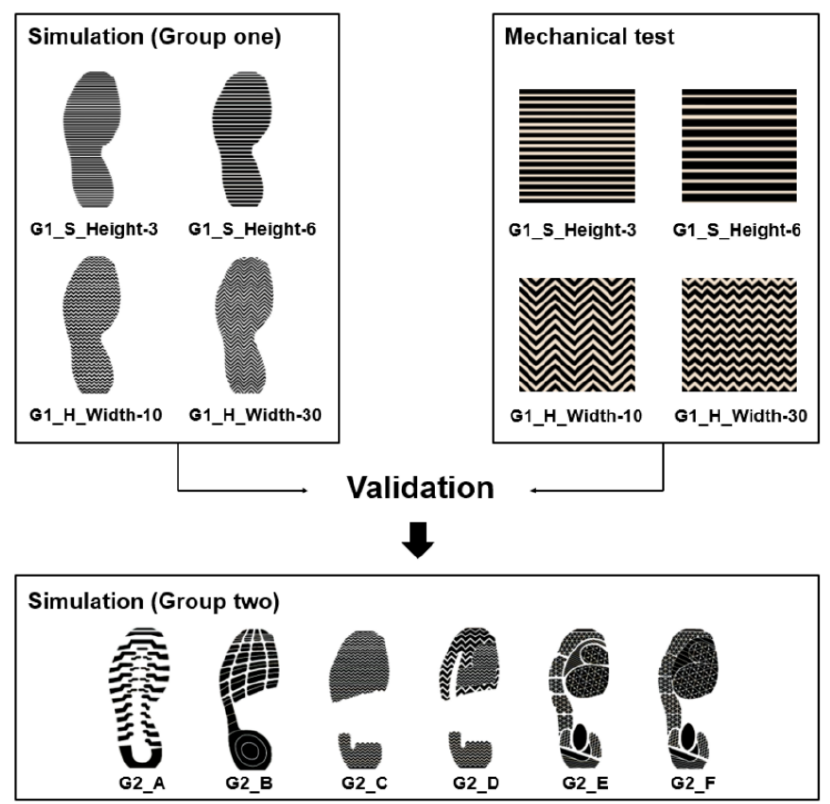
Figure 6. Flowchart of the experimental–computational process.